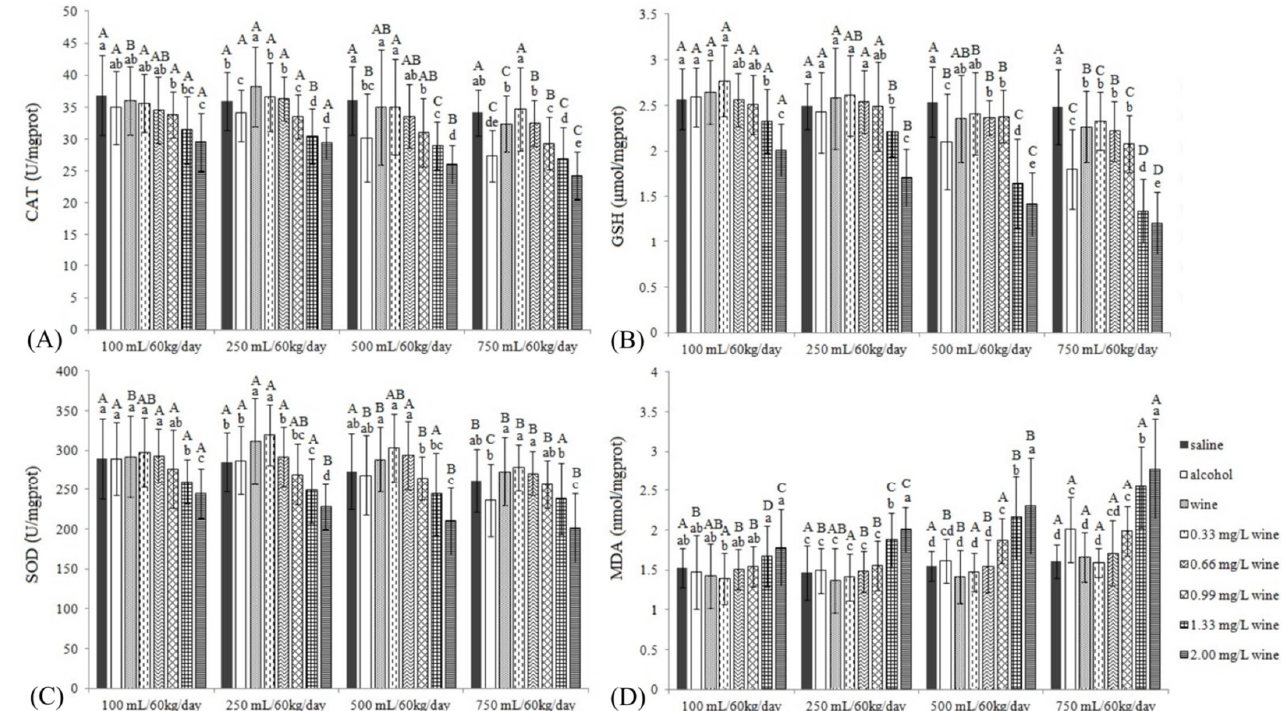
Figure 3. The CAT ( A ), GSH ( B ), SOD ( C ) and MDA ( D ) levels in mouse livers. Different capital letters indicate significant differences between treatment groups, and different lowercase letters indicate significant differences within the same dose groups ( p < 0.05).